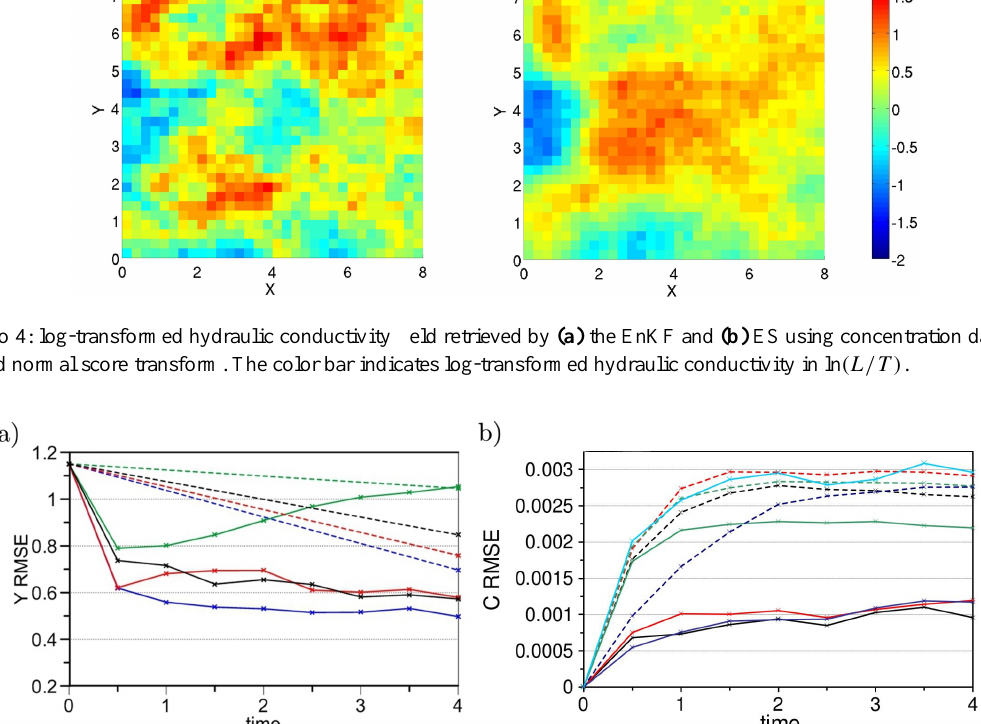
Fig. 9. Scenario 4: log-transformed hydraulic conductivity field retrieved by a) the EnKF and b) ES using concentration data transformed with a modified normal score transform. The color bar indicates log-transformed hydraulic conductivity in ln( L/T ).